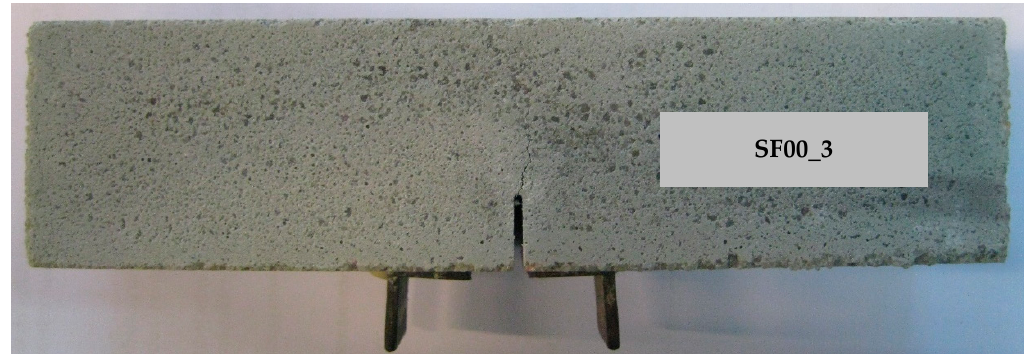
Figure 2. The selected reference specimen after the fracture test was performed with crack propagation from initial notch; detail of blades fixed close to the initial notch used for measurement of CMOD .